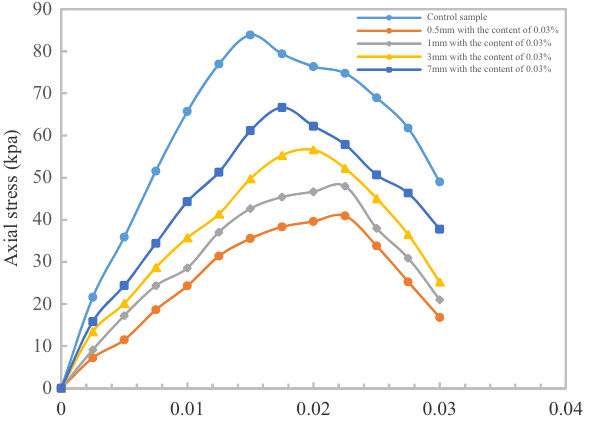
Figure 7: The stress – strain curves of di ff erent particle sizes with EPS reinforcement ratio of